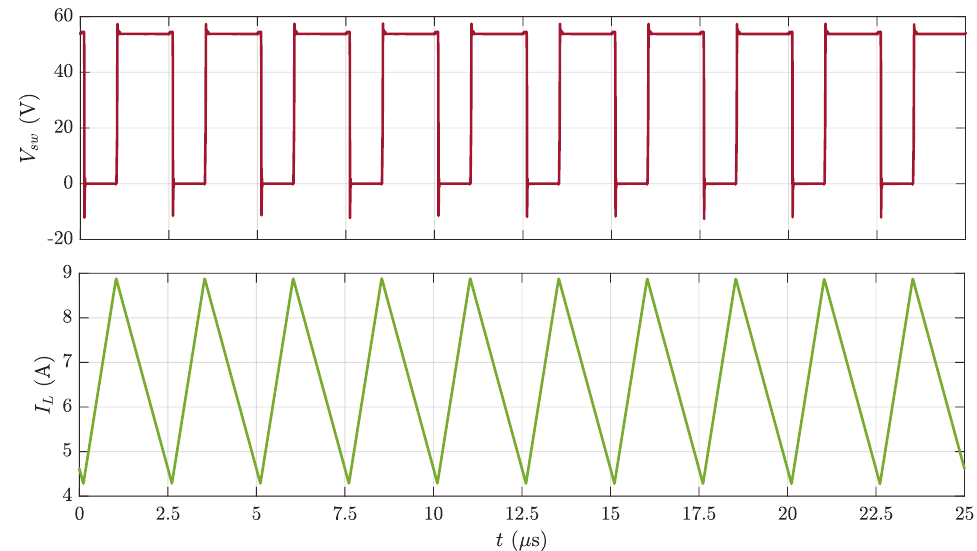
Figure 12. Switching node voltage ( top ). Inductor current ( bottom ).